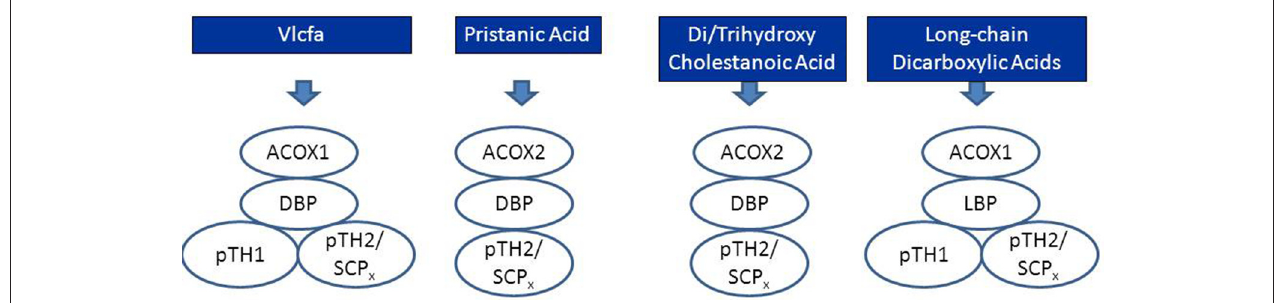
FIGURE 4 | Schematic diagram depicting the peroxisomal enzymes involved in the degradation of very long-chain fatty acids (VLCFAs), pristanic acid, di- and trihydroxycholestanoic acid, and long-chain dicarboxylic acids. See text for detailed information.